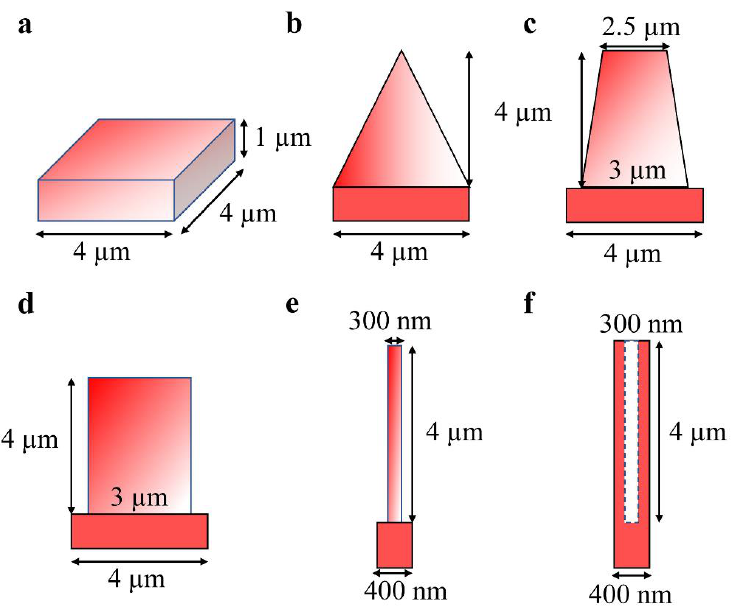
Figure 3. The detailed modeling information of unit cells about different microstructures, including: ( a ) planar silicon, ( b ) cone, ( c ) round column, ( d ) square column, ( e ) Si-NWAs and ( f ) Si-NHAs.